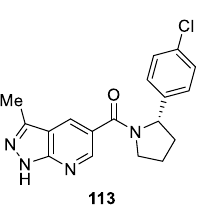
Figure 23. Chemical structure of imidazo-thiadiazole derivative 113 .